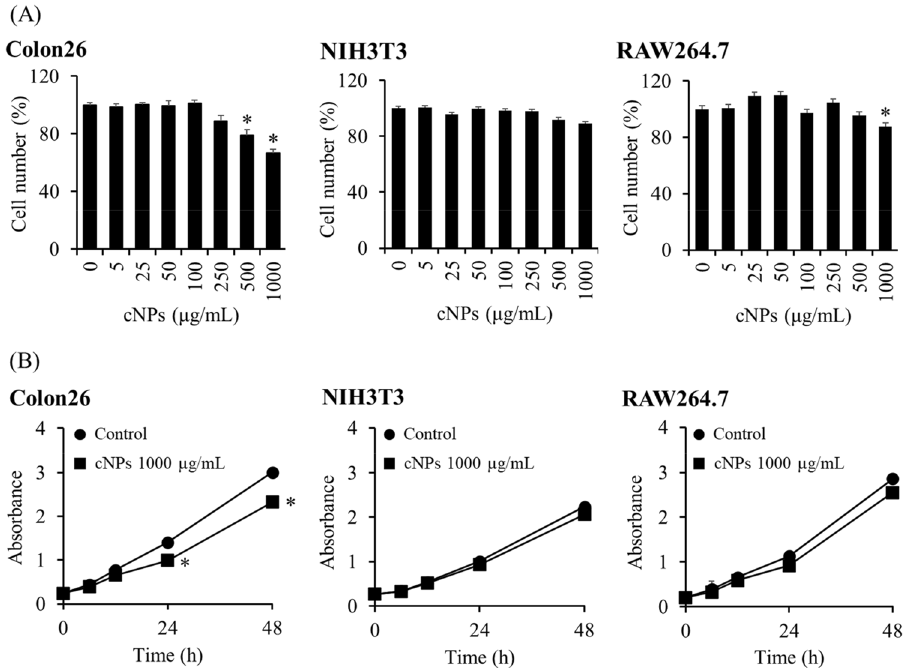
Figure 3. Cell number and proliferation after incubation with cNPs. (A) Cell number was measured by Cell Counting Kit-8 (CCK8) assay after 24 h of cNP addition. Colon26, NIH3T3, and RAW264.7 cells were incubated with 5–1000 μg/mL of cNPs. Results are expressed as the mean ± SD of four samples. *p < 0.05 vs. 0 μg/mL cNP group (the control group). (B) Cell proliferation was measured by CCK8 assay after 6, 12, 24 and 48 h of 1000 μg/mL cNP addition. Results are expressed as the mean ± SD of four samples. *p < 0.05 vs. control group.